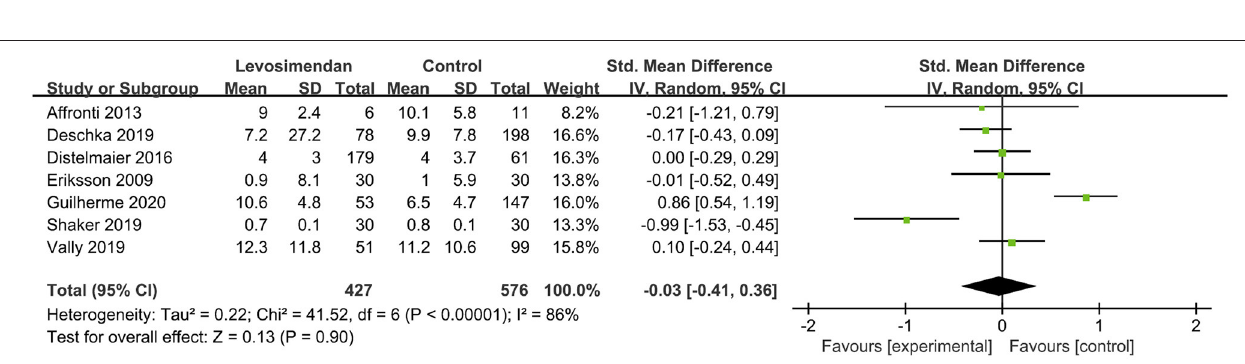
Frontiers in Medicine |